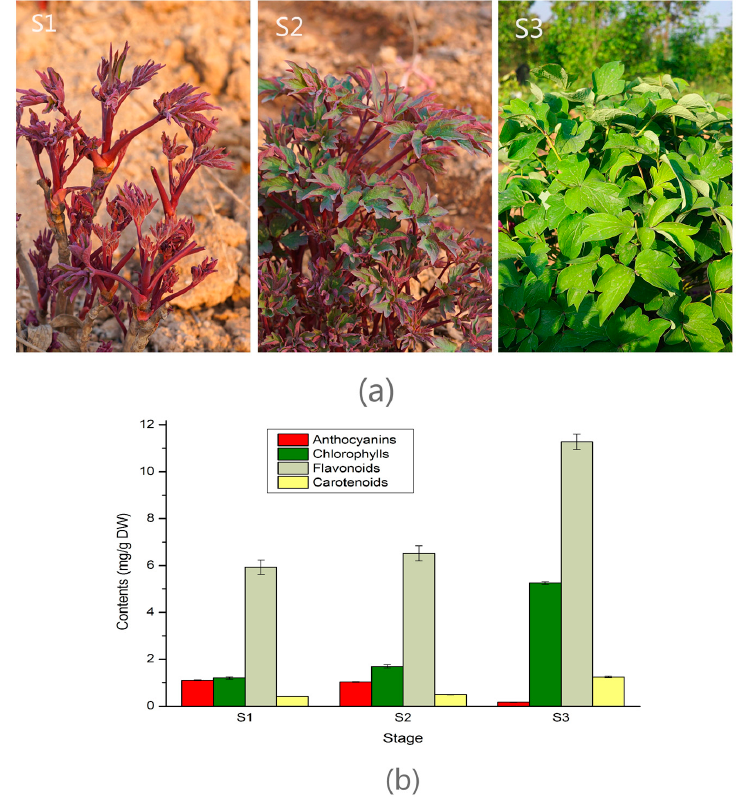
Figure 1. Images of tree peony leaf and pigments contents at three stages. ( a ) Images of tree peony leaf at three different stages; ( b ) contents of anthocyanin, chlorophyll, total flavonoid, and carotenoid in the leaf of three different stages.